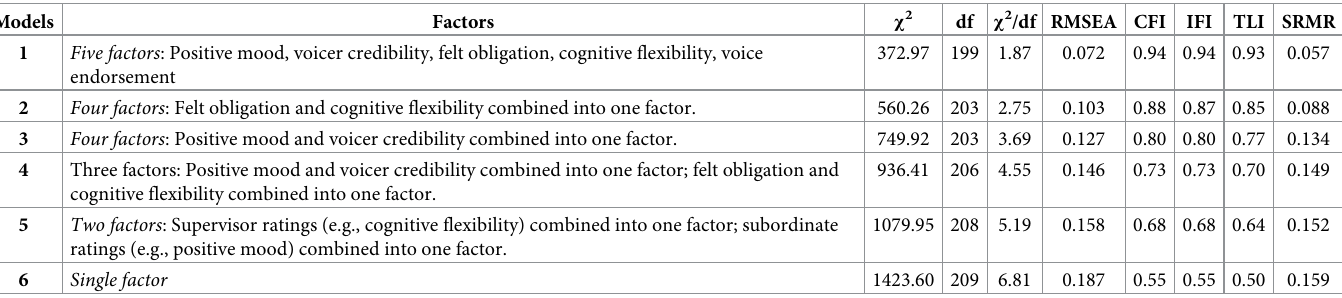
Table 2. Comparison of measurement